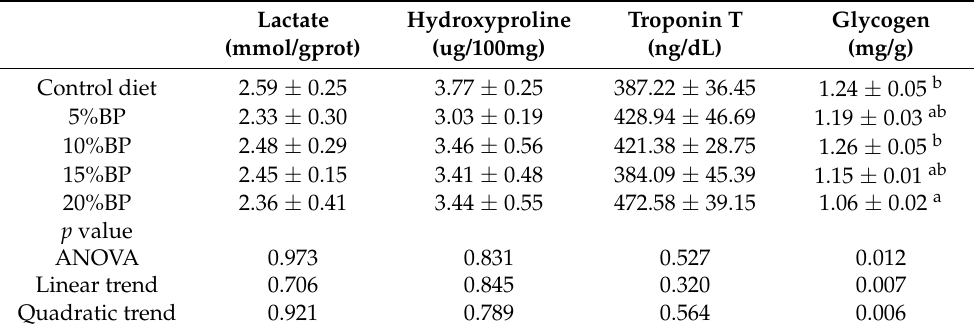
Table 7. Muscle enzyme activity in grass carp fed a diet with paper mulberry (BP) for 8